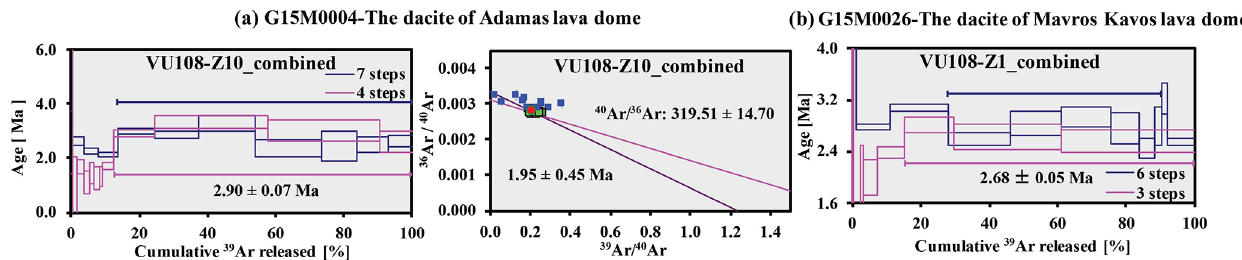
Figure 9. Amphibole 40 Ar / 39 Ar plateau or inverse isochron ages for samples G15M0004 (a) and G15M0026 (b) . Final age calculation is reported with 1 σ errors. The Adamas and Mavros Kavos lava domes are located in the northern and south-western parts of the Milos VF, respectively (see Fig. 2). See the individual steps of samples G15M0004 and G15M0026 in Supplement file